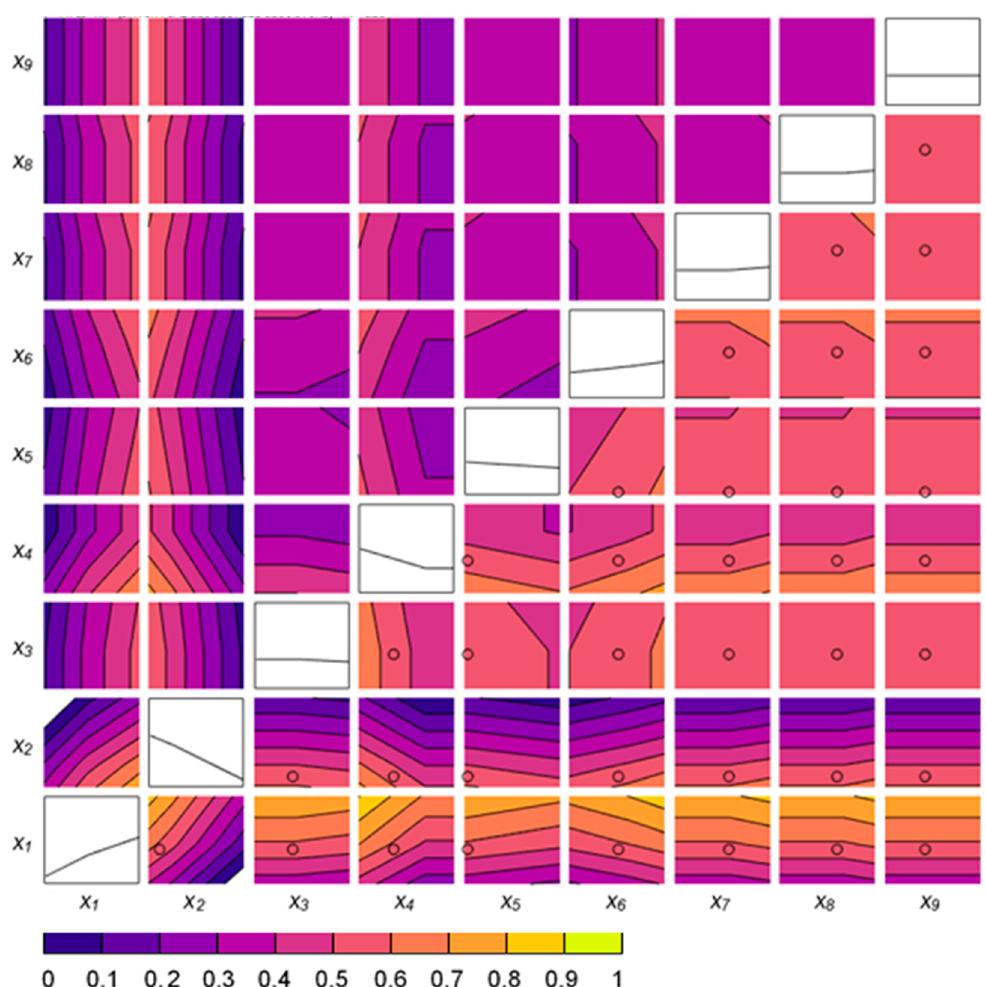
Figure 6. Graphical representation of the final MARS model { S = 1, I = 1, M F = 21, d = 2, L = 4, w = 2000} at heat number t = 11,755. The diagonal elements of the mosaic are the line plots of the predicted hot metal temperature, ˆ y t , versus each individual input variable, x i . The other mosaic elements are the response surfaces of the model for any combination of two variables ( x i , x j ); the contour plots below the diagonal are traced around the actual value of 𝑥⃗ at t = 11,755: 𝑥⃗ (cid:3047) = (0.41, 0.14, 0.42, 0.38, 0.054, 0.53, 0.58, 0.61, 0.43) whereas the graphs above the diagonal are traced around the mid ‐ point of the range of 𝑥⃗ = (0.5, 0.5, 0.5, 0.5, 0.5) axes limits are [0,1] for all the variables.